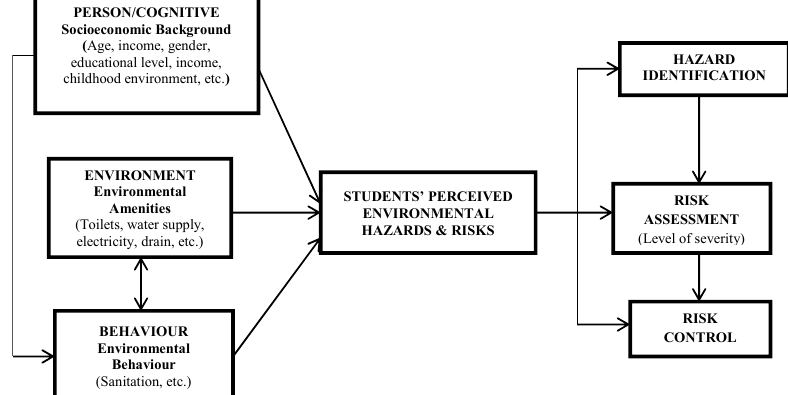
Fig. 2: Students’ environmental hazard and risks perception framework